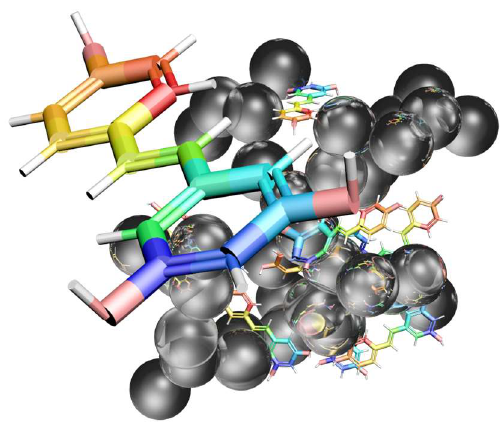
Figure 1. Diagram of resveratrol adsorption on silica aerogel.